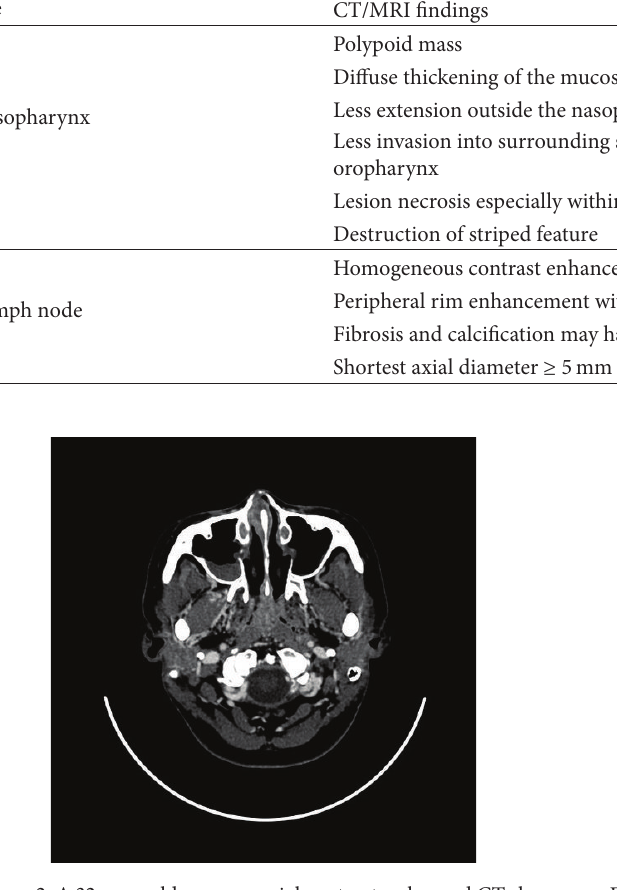
Figure 2: A 32-year-old woman, axial contrast-enhanced CT shows diffuse mucosal thickening without invasion into surrounding structures.